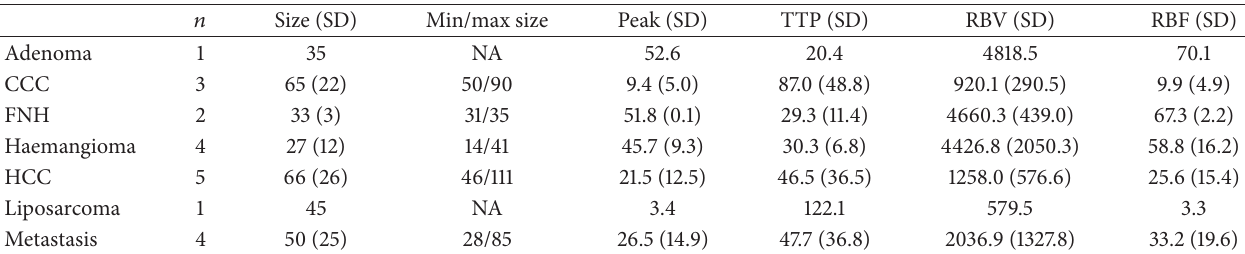
Table 2: Size of the lesions (in mm) and their perfusion parameters.